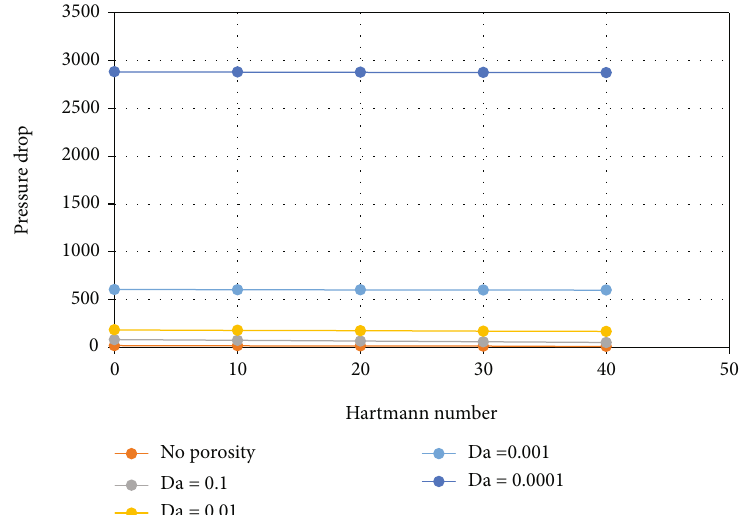
Figure 8: The impact of the Hartmann and Darcy numbers on the pressure drop in water and 0.2 nano fl uids. The direction of the magnetic fi eld is in the y -direction ( ψ = 90